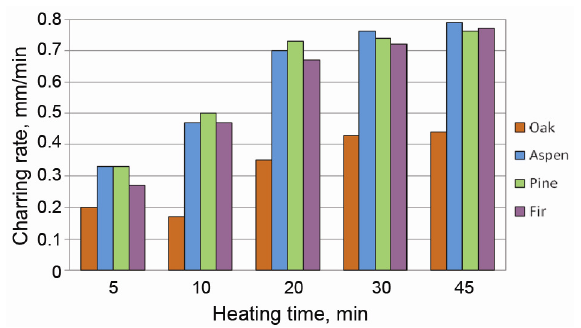
Fig. 11. Average values of charring rates for wood samples